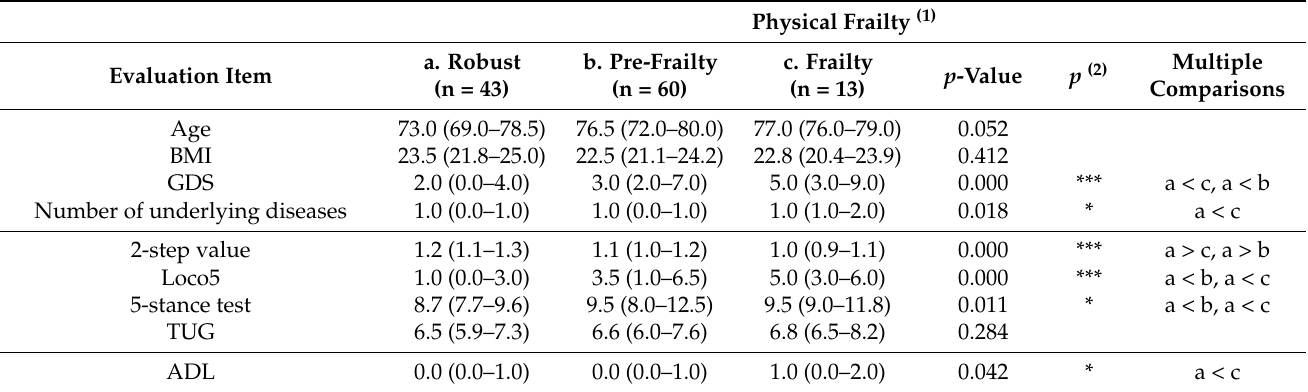
Table 2. Comparison of groups classified by physical